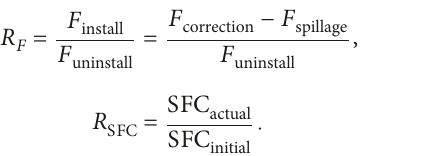
Figure 13: Control schedule of variable geometries (11 km,